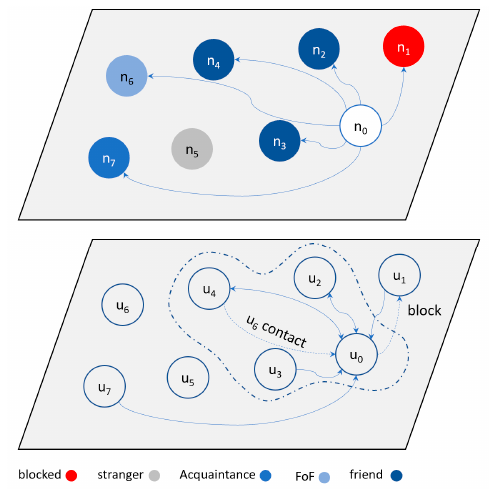
Figure 2. WhatsTrust relations model.